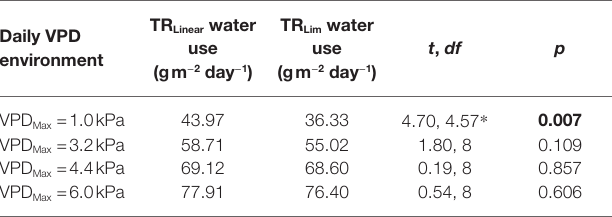
TABLE 5 | Effect of water and VPD environment during peak flowering on lint yield of four cotton genotypes (CSX2027, CSX8521, Sicot 80BRF, and Sicot 746B3F) grown across Australian cotton regions from 2006 to